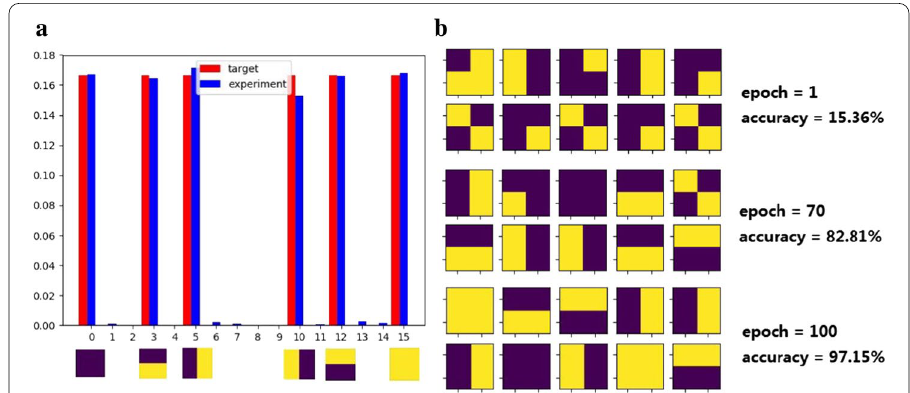
2 Bars-and-Stripes samples generated from QCGAN. a The final probability distribution of the Fig. 9 2 × generative BAS data. b BAS samples generated from QCGAN with different epoch (For illustrative purpose, we only show 10 samples for each